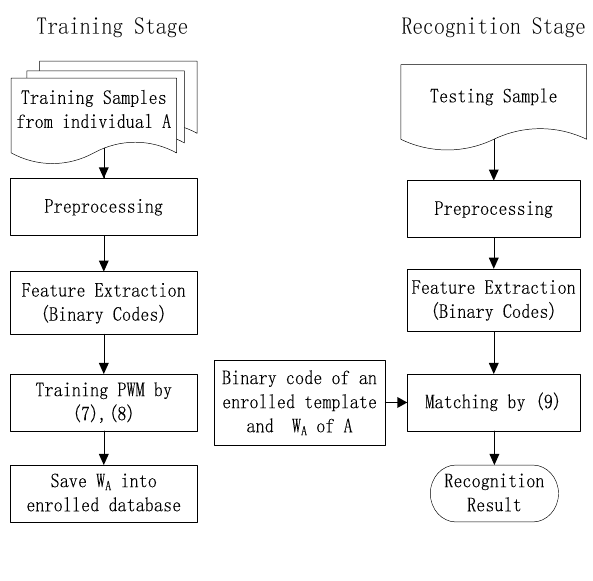
Figure 4. Framework of the proposed method.